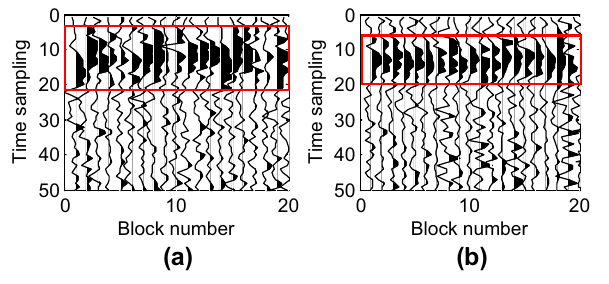
Fig. 3 Grouping results. a Matching in time domain. b Matching in wavelet domain